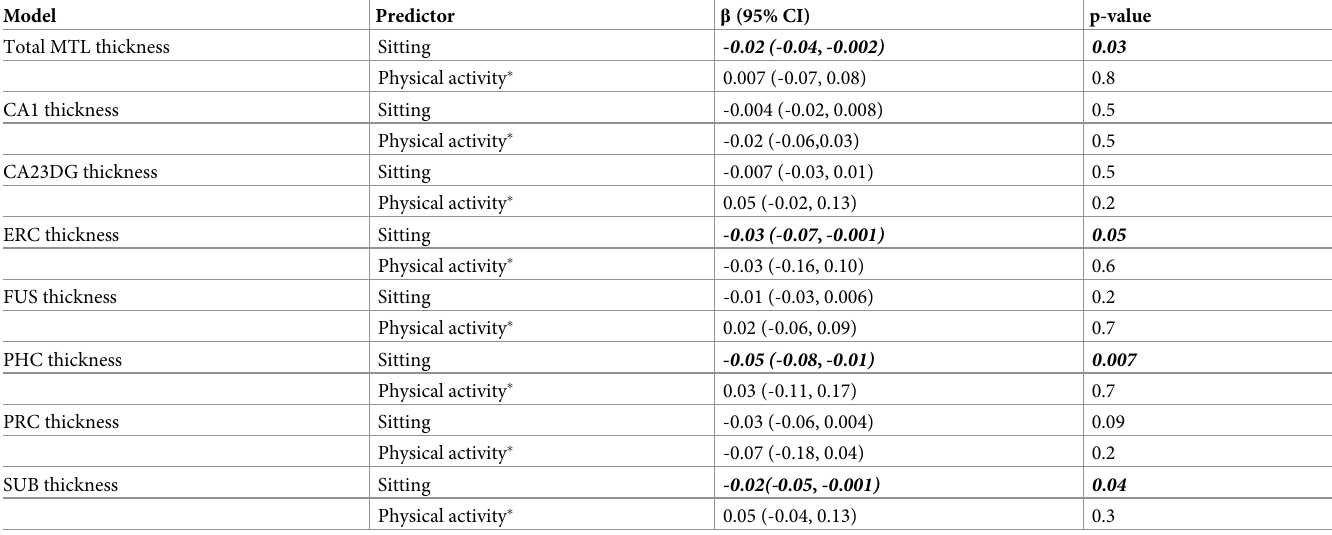
Table 2. Predictors of total and regional medial temporal lobe (MTL)